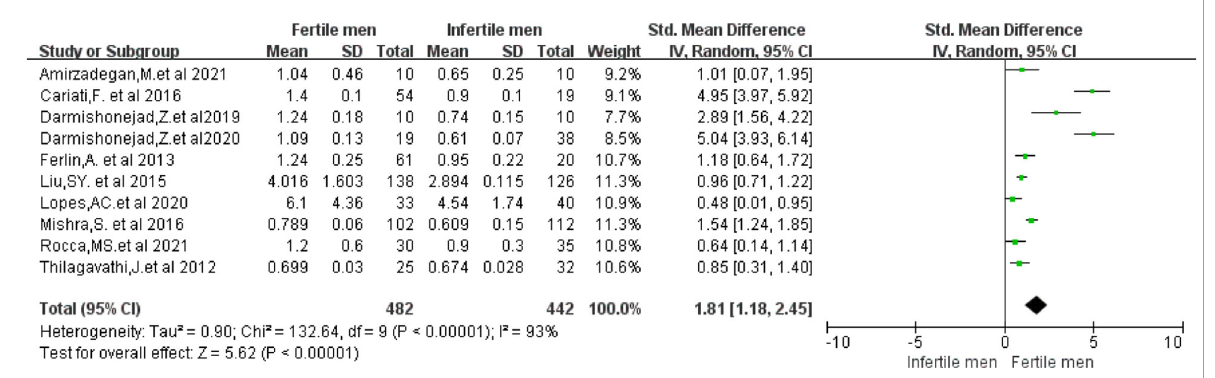
FIGURE 2 Forest plot showing the results of Meta-analysis, comparing fertile and infertile men for differences in